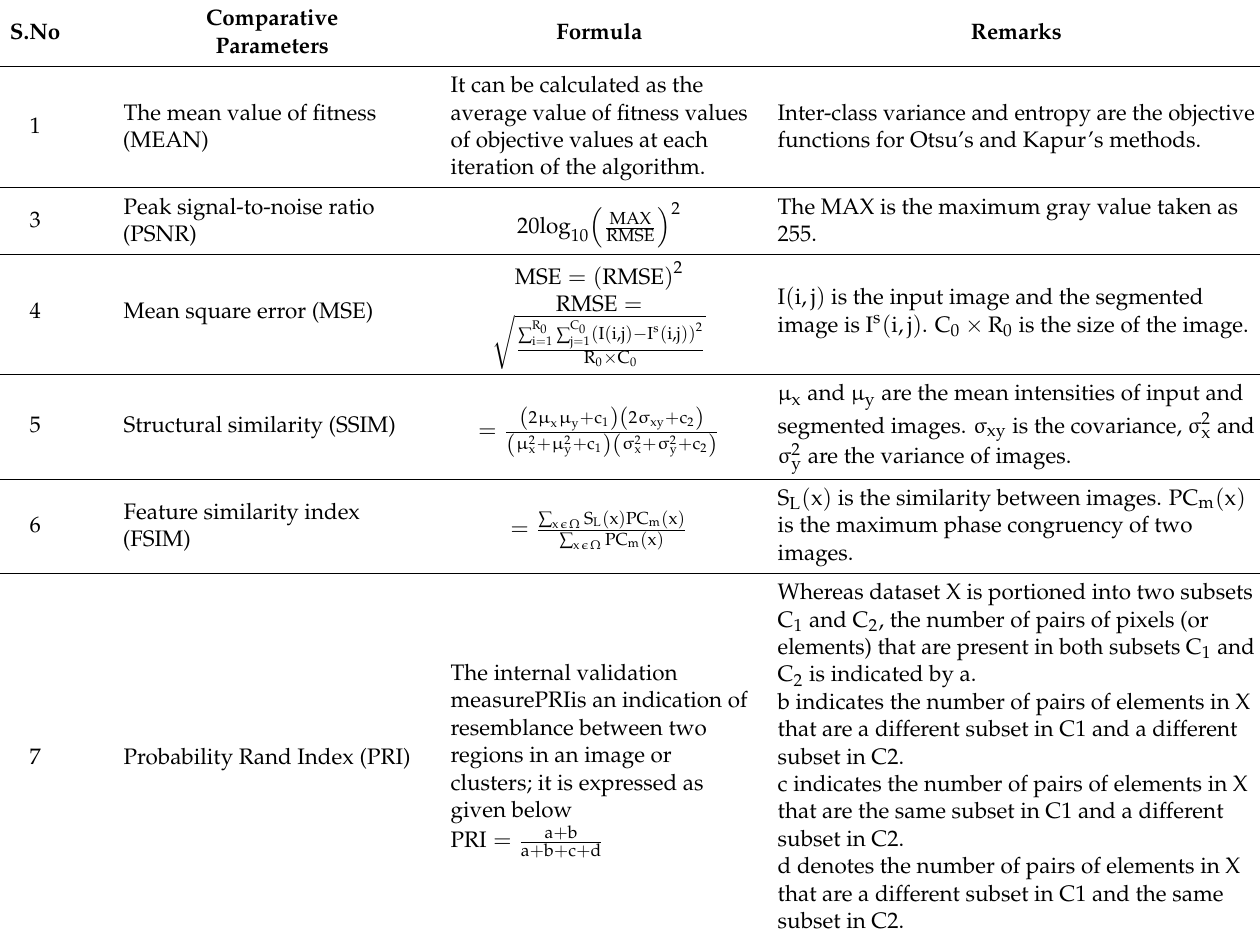
Table 1. Different metrics to test the efficiency of the